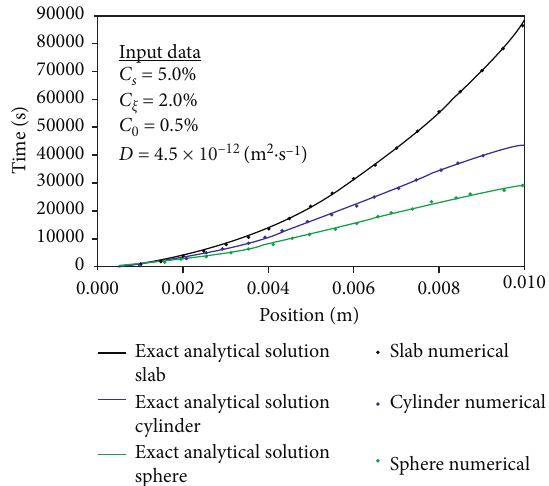
Figure 7: Comparison between numerical and analytical solutions for diffusion times during inward diffusion of a slab, a cylinder, and a sphere.